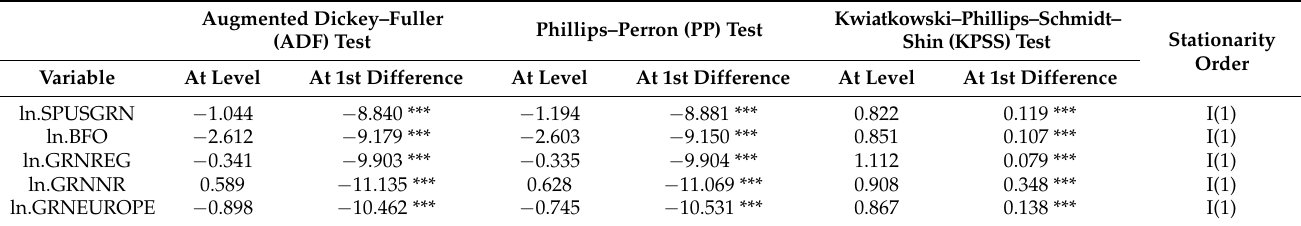
Table 3. Unit root tests of the variables.